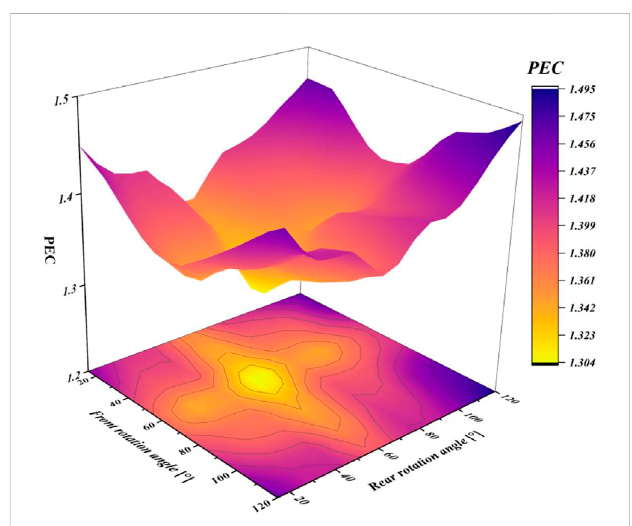
FIGURE 14 Effects of the front and rear rotation angle on PEC (Re =